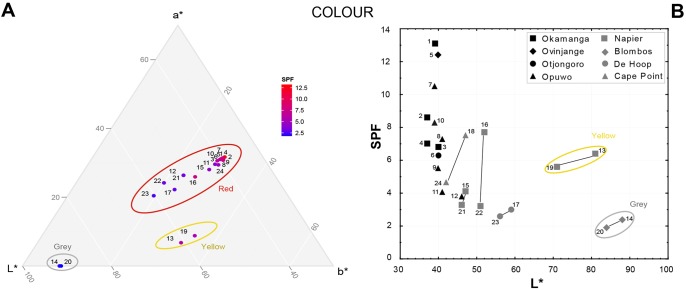
Ternary diagram (A) and biplot (B) illustrating the relationship between SPF values and ochre colour.